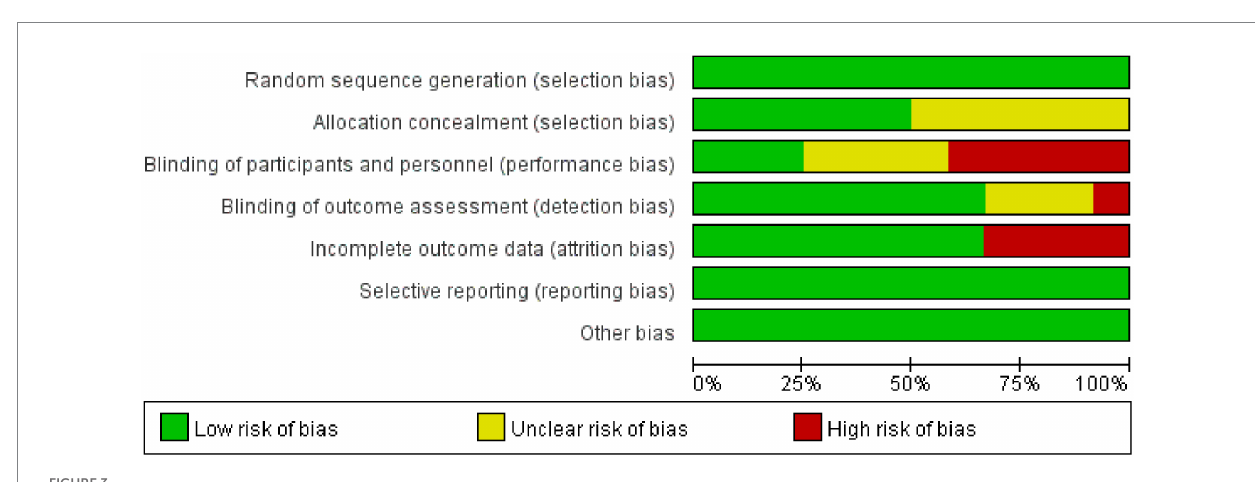
FIGURE 3 Risk of bias items as percentages across all included